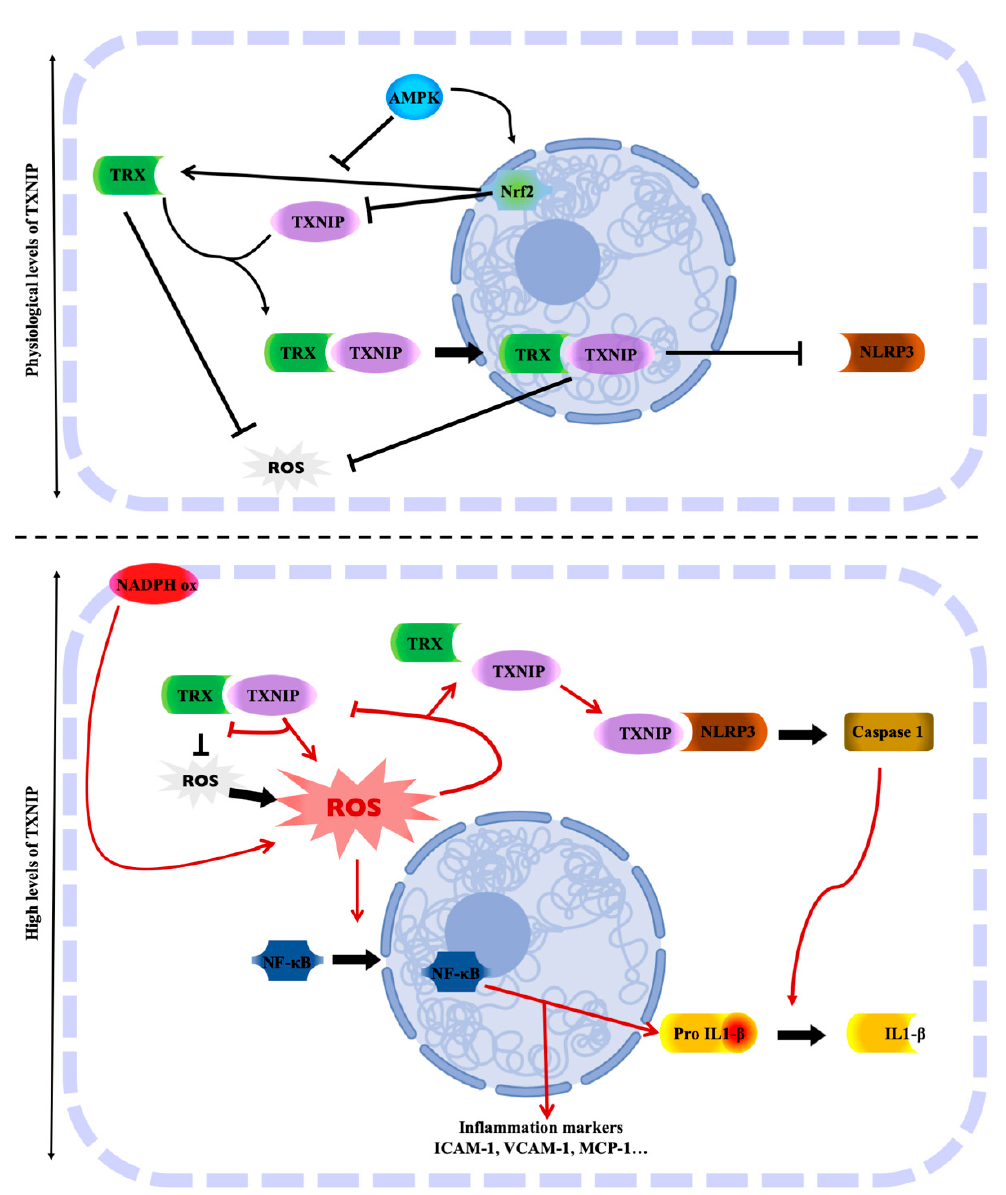
Figure 1. TXNIP is the molecular link between the regulation of oxidative stress and inflammation. Physiological levels of TXNIP balance the regulation of TRX oxidative stress. TRX is free from TXNIP, whose level is controlled by several factors. However, high levels of TXNIP inhibit TRX activity, resulting in oxidative stress with the accumulation of ROS. The oxidative stress status allows TXNIP to activate the NLRP3 inflammasome and trigger cell inflammation. Created with Bio- Render.com.